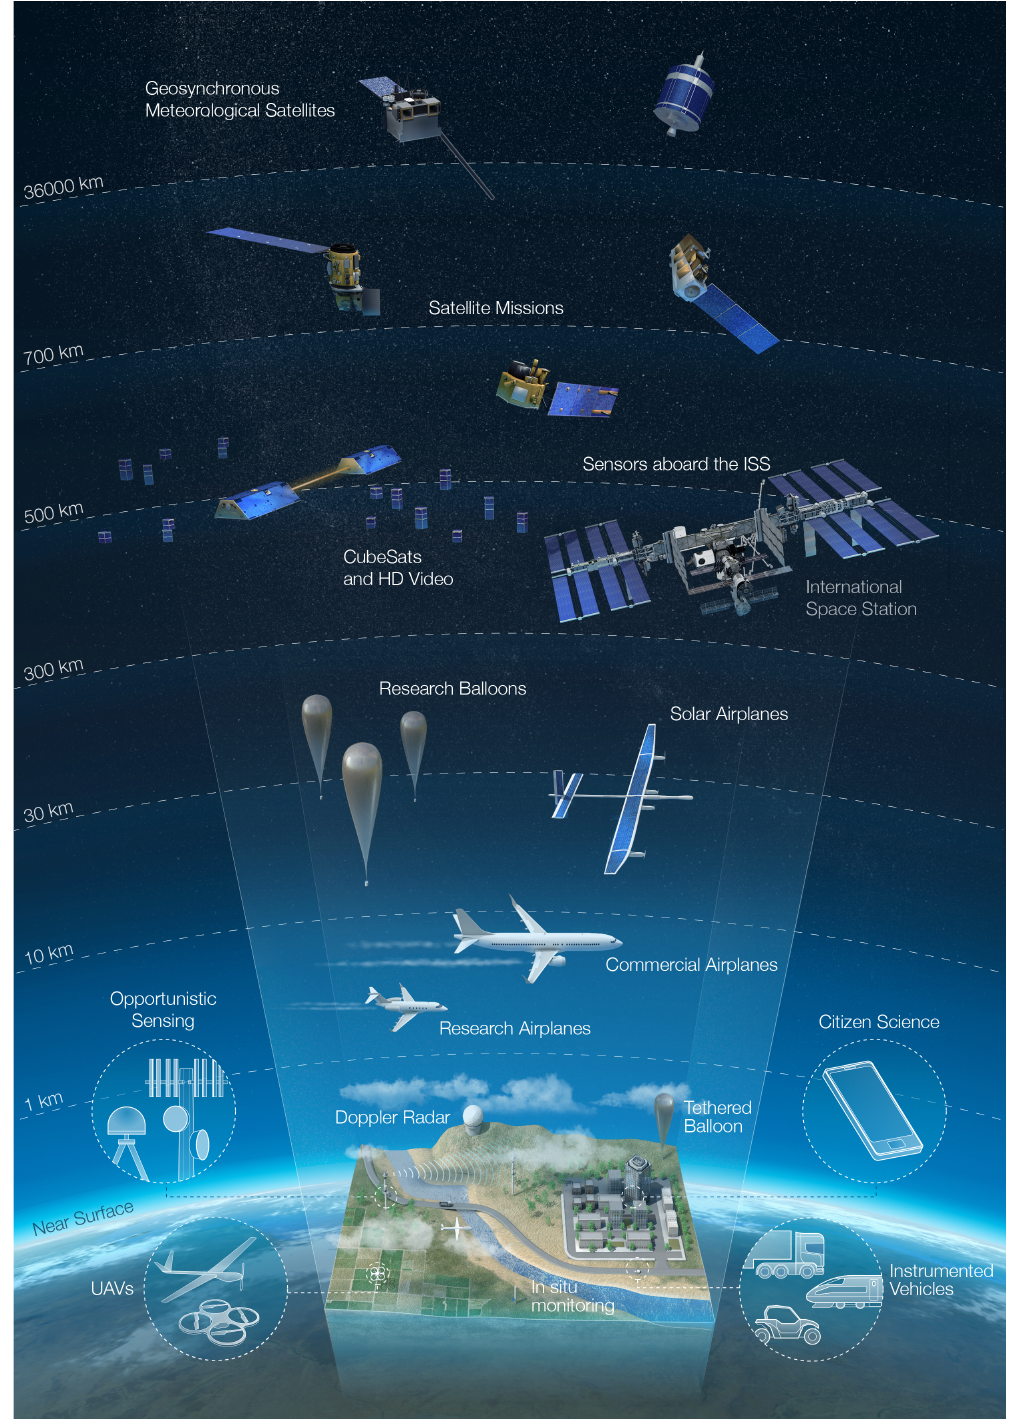
Figure 2. An Earth-observing “system of systems” for revolutionizing our understanding of the hydrological cycle. This multi-scale, multi- resolution observation strategy is not really a concept, as the technology exists and is largely in place now. Supporting traditional space-based satellites, there are now a range of orbital options from commercial CubeSats to demonstration sensors on-board the International Space Sta- tion. Beyond orbiting EO systems, technological advances in hardware design and communications are opening the skies to stratospheric balloons and solar planes, as well as an explosion of UAV-type platforms for enhanced sensing. At the ground level, the ubiquity of mo- bile devices are expanding traditional in situ network capacity, while proximal sensing and signals of opportunity are opening up novel measurement